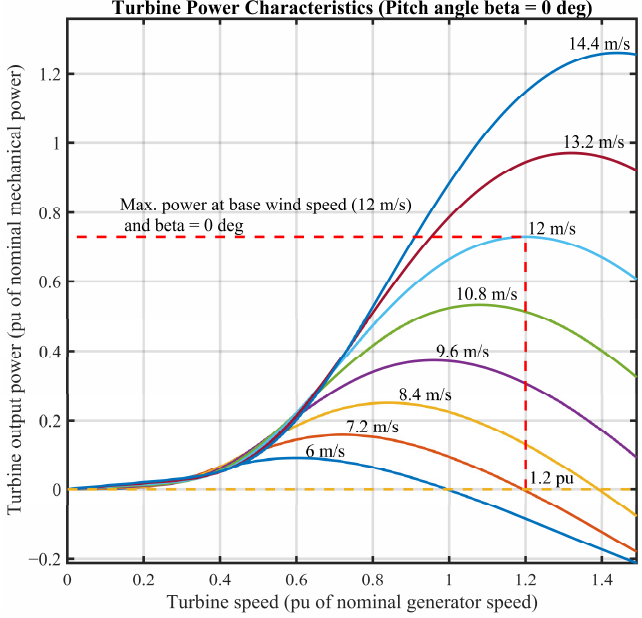
Figure 19. Wind turbine characteristics.